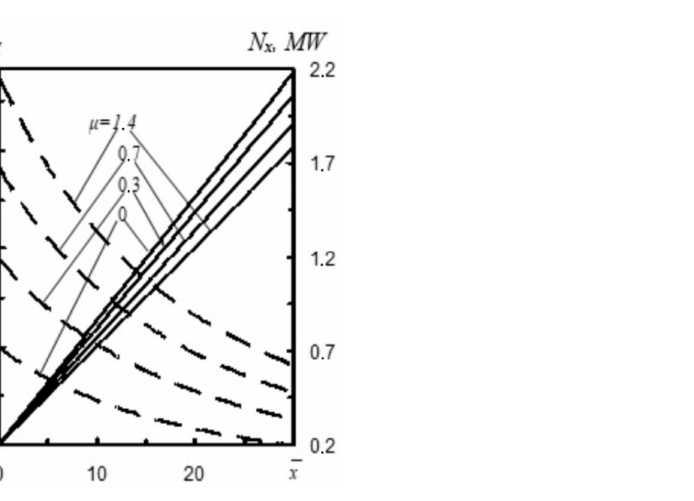
Figure 6. Mass g (—-) and stream power N x (- ) vs. mass consumption of refractory powder to mass consumption of nitrogen µ ratio at a distance x from the nozzle cross section [17].